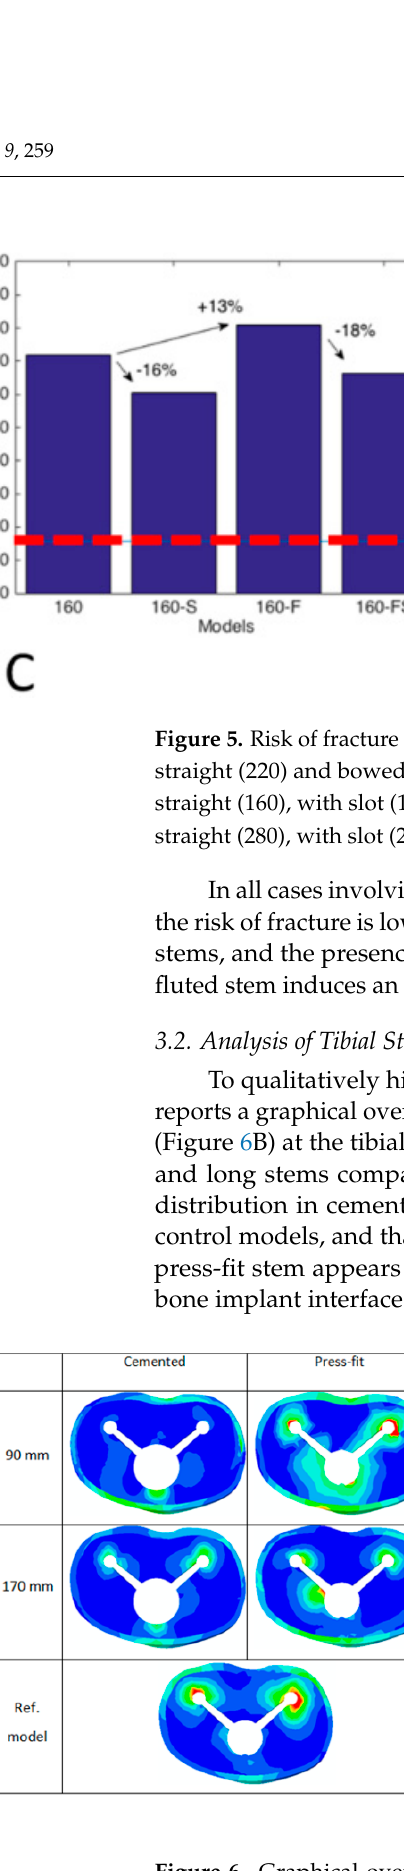
Figure 6. Graphical overview of the von Mises stress ( A ) and of the contact pressure ( B ) at the tibial- bone interface for cemented and press-fit configurations, for stems of 90 mm or 170 mm in length, compared with the reference model in which no stem is present. Quantitatively, Figure 7 reports the average von Mises stress in the different regions of interests (also illustrated in the figure) for the medial and lateral side. Generally, the